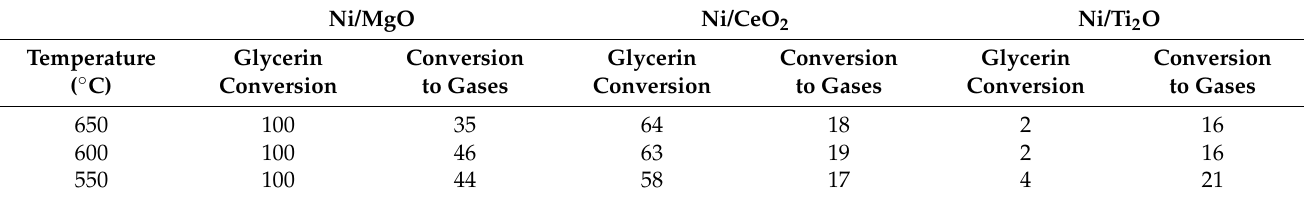
Table 5. Glycerin conversion and conversion into gaseous products over Ni-supported catalysts. Ni/MgO Ni/CeO 2